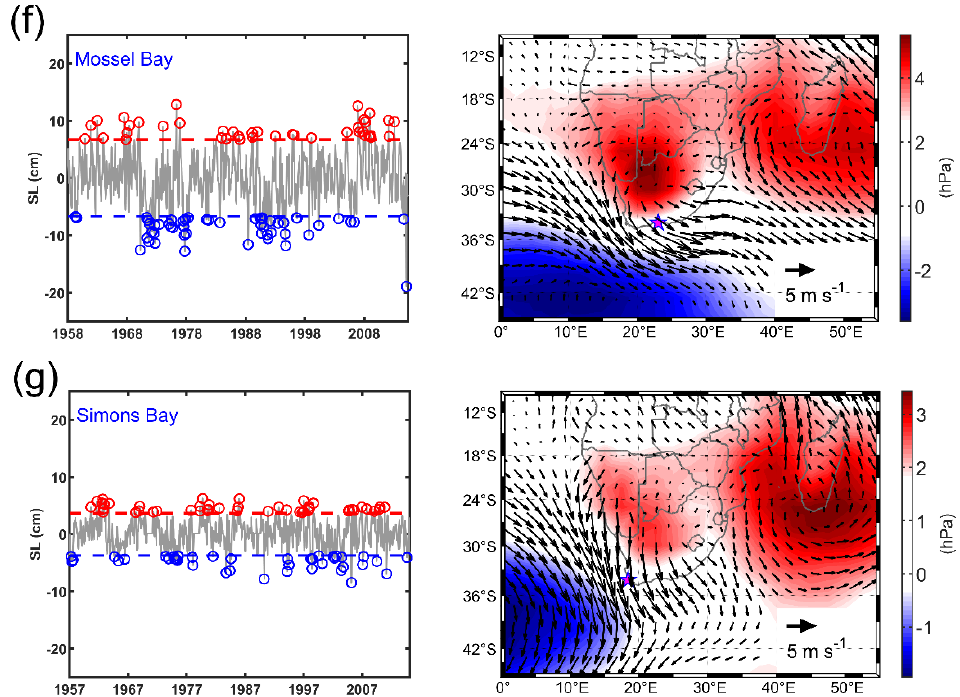
Figure 5. ( Left ) Monthly mean sea level, with high events (>1.5 standard deviations, red circles) and low events (<1.5 standard deviations, blue circles) at different tide stations. ( Right ) Composite mean of the differences of the SLP (colour) and 10 m winds (vectors) corresponding to high and low events in the sea level at ( a ) Richards Bay, ( b ) Durban, ( c ) East London, ( d ) Port Elizabeth, ( e ) Knysna, ( f ) Mossel Bay and ( g ) Simons Bay, respectively. Magenta stars indicate the tide gauge location.